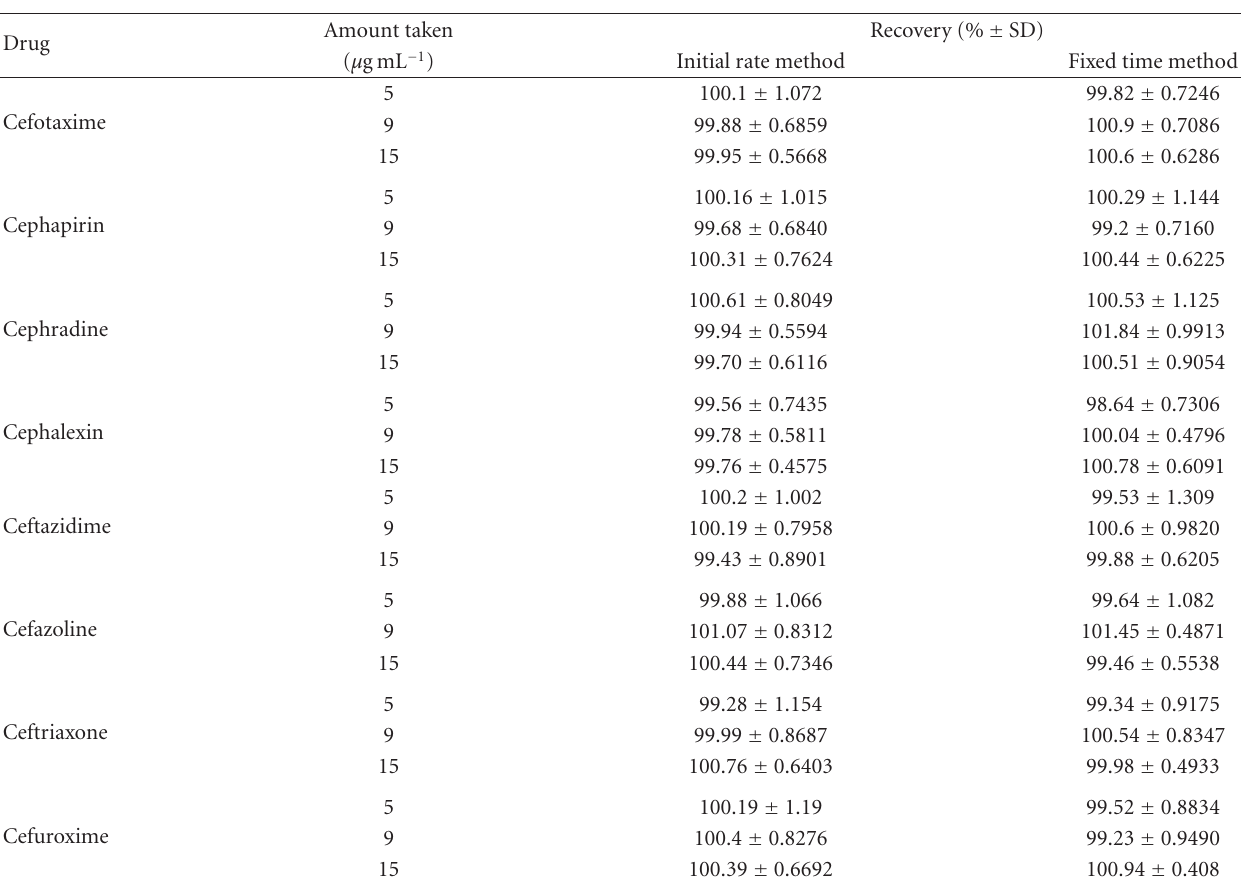
Table 6: Evaluation of precision of the initial rate and fixed time methods of the proposed kinetic spectrophotometric method for determination of investigated